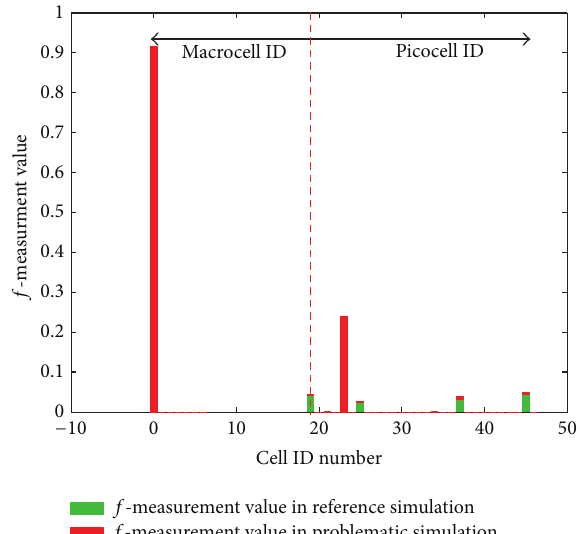
Figure 5: The distribution of 𝑓 -measurement values for RLF- labeled data in both reference and problematic